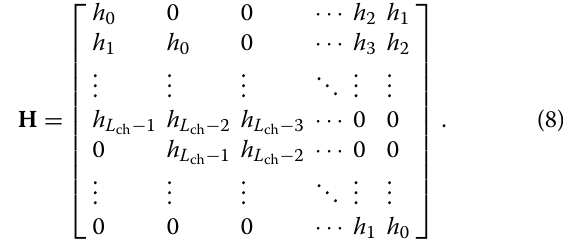
that is the transmit sequence to be mapped in U OFDM